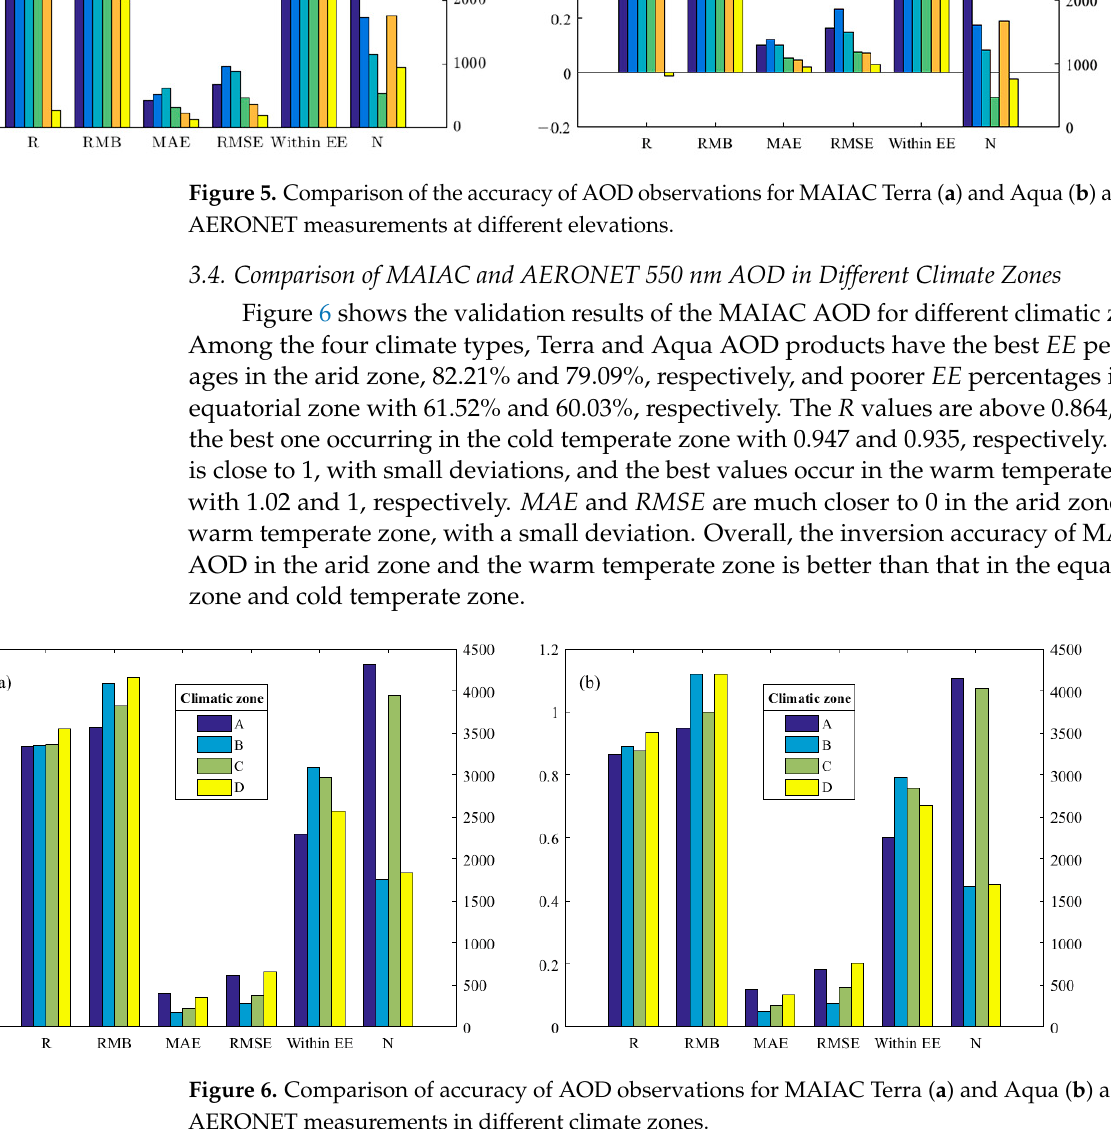
Figure 7. Spatial distribution and change rate of MAIAC AOD from 2011 to 2020.